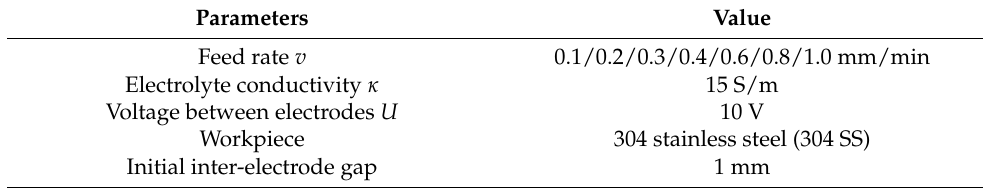
Table 2. ηω - i of 304SS. Table 1. Simulation